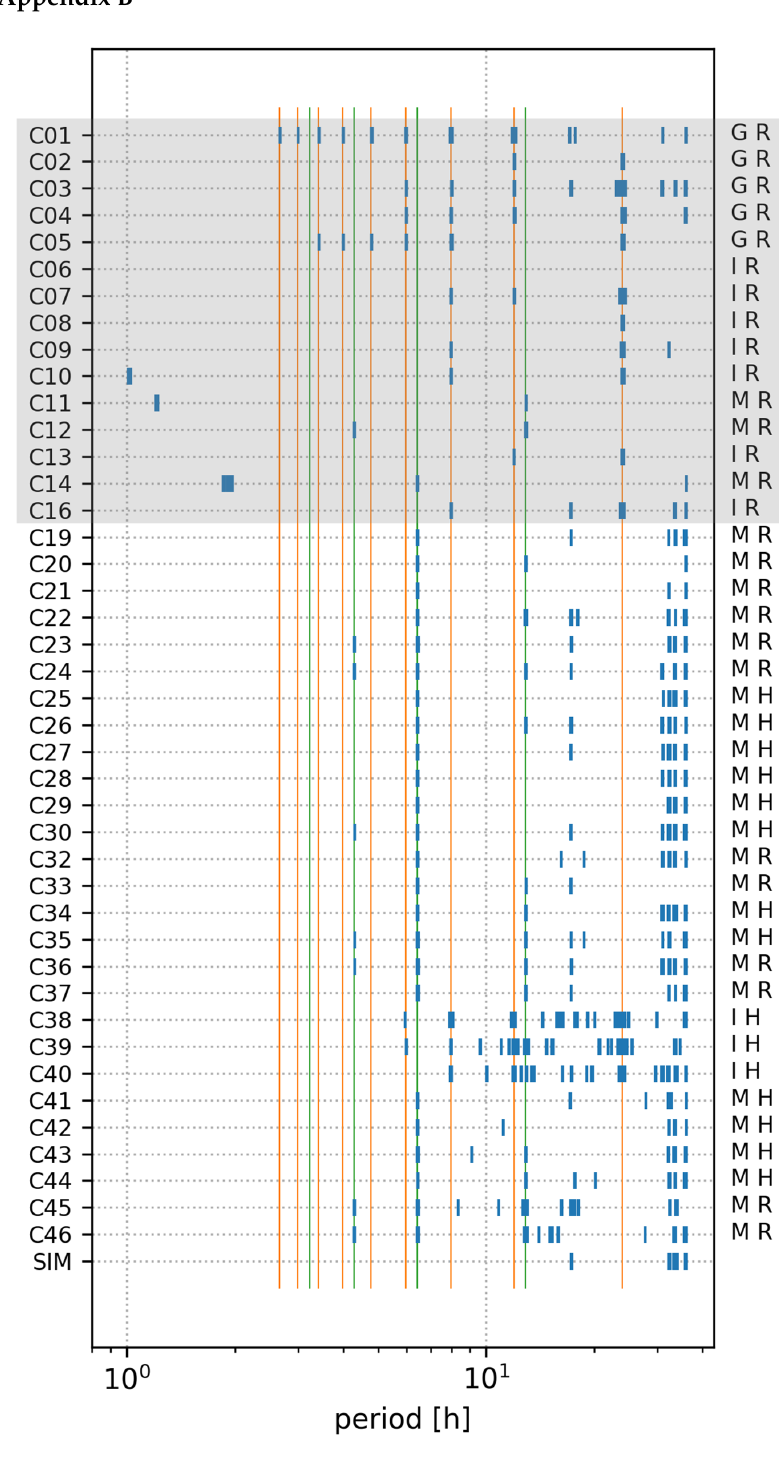
Figure A1. BeiDou BDS-2 (shaded grey) and BDS-3 satellites clock correction periodicity. The green lines correspond to BeiDou MEO satellites orbital period and its 2nd, 3rd and 4th harmonics. The orange lines correspond to GEO and IGSO satellites orbital periods and their harmonics up to 9. Spurious periods of 17 h and 30–40 h visible in the clock correction are caused by frequent jumps in the analysed signal (same as for simulated SIM data). The letters on the right side of diagram provide information on the particular satellite orbit and its clock: G—geostationary orbit, I—inclined geosyn- chronous orbit, M—Medium Earth orbit, R—rubidium clock, H—hydrogen maser.